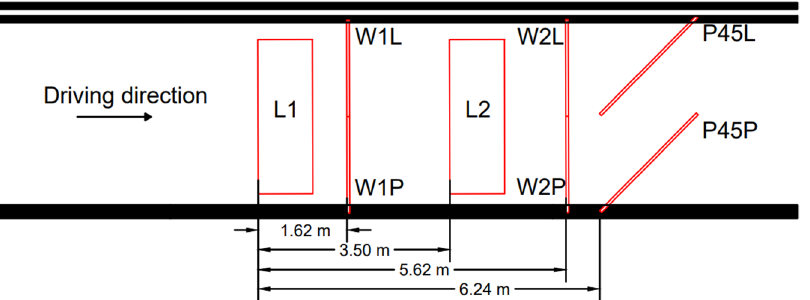
Figure 5. Sensor layout (L1, L2—loop sensors; W1L, W1P, W2L, and W2P—strain gauge load cell sensors; P45L, P45P—piezoelectric sensors).